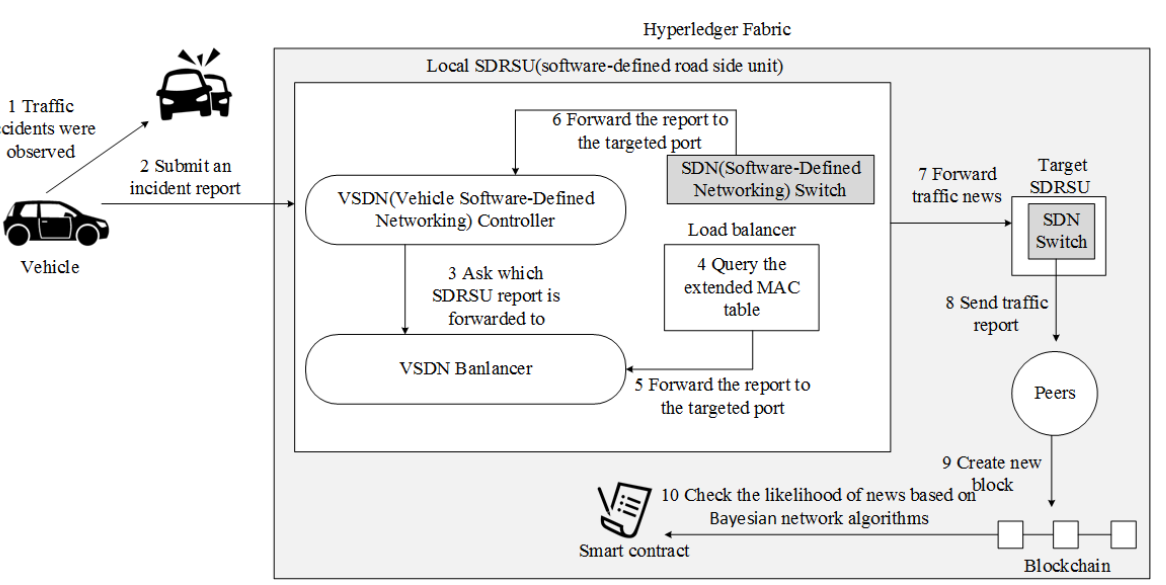
Figure 37. Reconstruction diagram of reference [69].